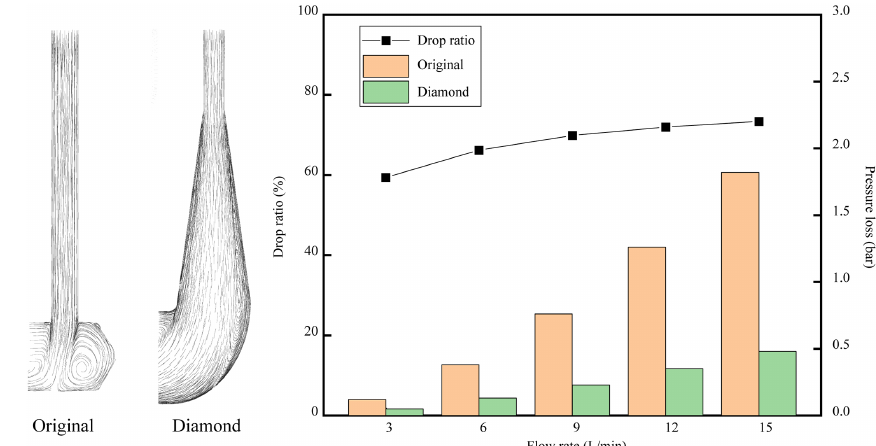
Figure 13. Pressure loss at different flow rates.